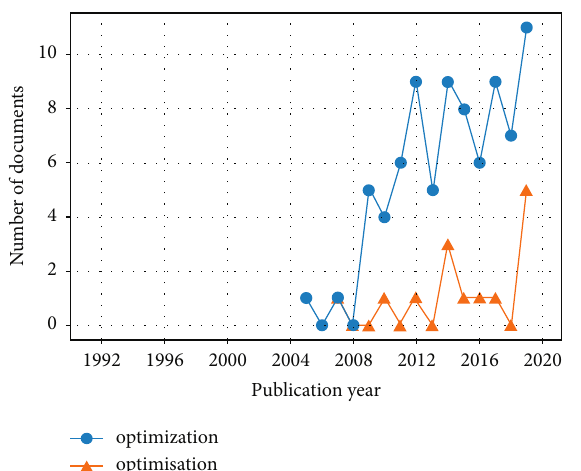
Figure 6: Timeline graph for publications with decision-making or decision making as keywords during the period 1991–2020.